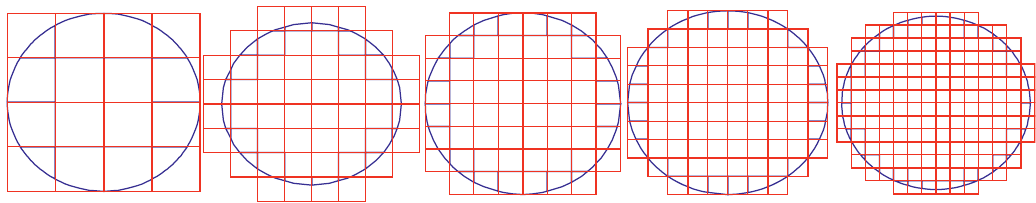
Figure 9: Meshes with different element sizes of a clamped circular plate divided for the proposed NMM and the traditional NMM; from left to right: 0.5 × 0.5, 0.3 × 0.3, 0.25 × 0.25, 0.2 × 0.2, and 0.15 × 0.15.